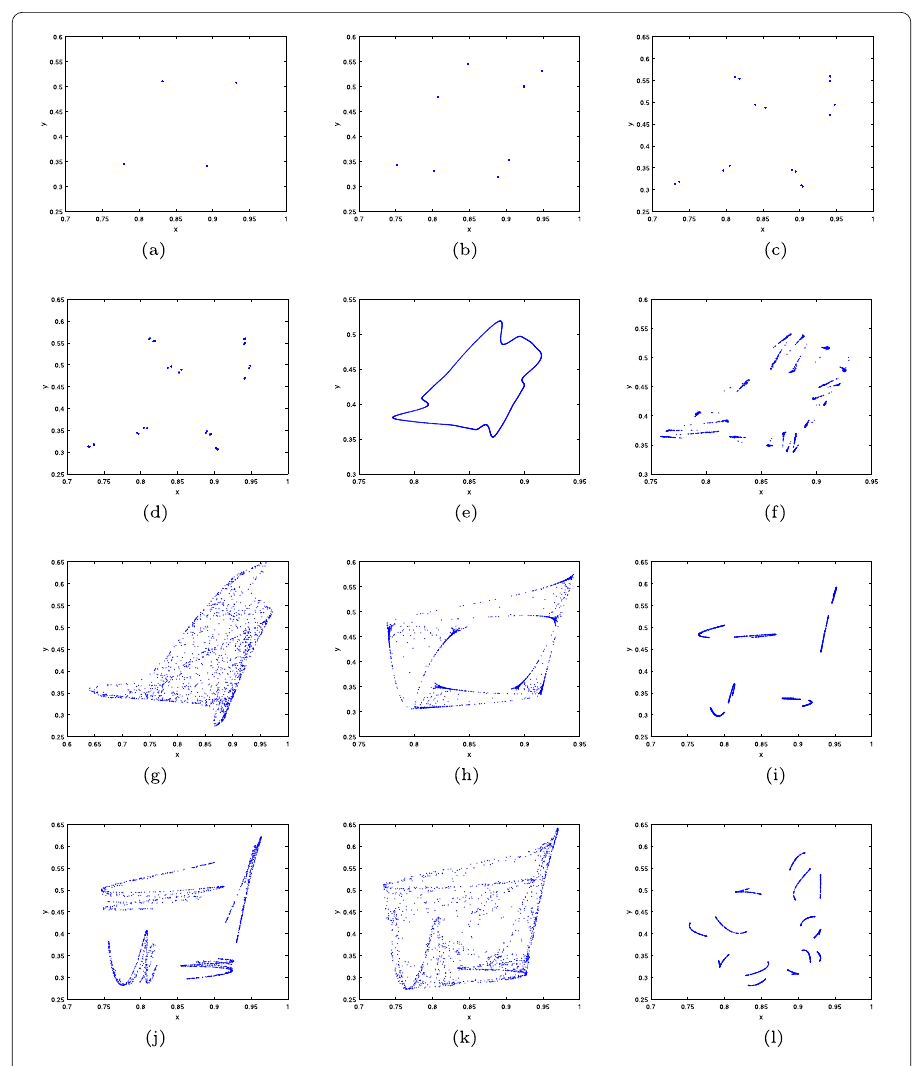
Figure 7 Phase portraits for various values of ( ρ 1 , μ ) corresponding to Fig. 6. ( a ) ρ 1 = 1.4, μ = 3.615; ( b ) ρ 1 = 1.4, μ = 3.639; ( c ) ρ 1 = 1.4, μ = 3.667; ( d ) ρ 1 = 1.4, μ = 3.668; ( e ) ρ 1 = 1.6, μ = 3.5673; ( f ) ρ 1 = 1.6, μ = 3.5948; ( g ) ρ 1 = 1.6, μ = 3.6448; ( h ) ρ 1 = 1.2, μ = 3.6723; ( i ) ρ 1 = 1.2, μ = 3.6873; ( j ) ρ 1 = 1.2, μ = 3.7099; ( k ) ρ 1 = 1.2, μ = 3.7249; ( l ) ρ 1 = 1, μ =